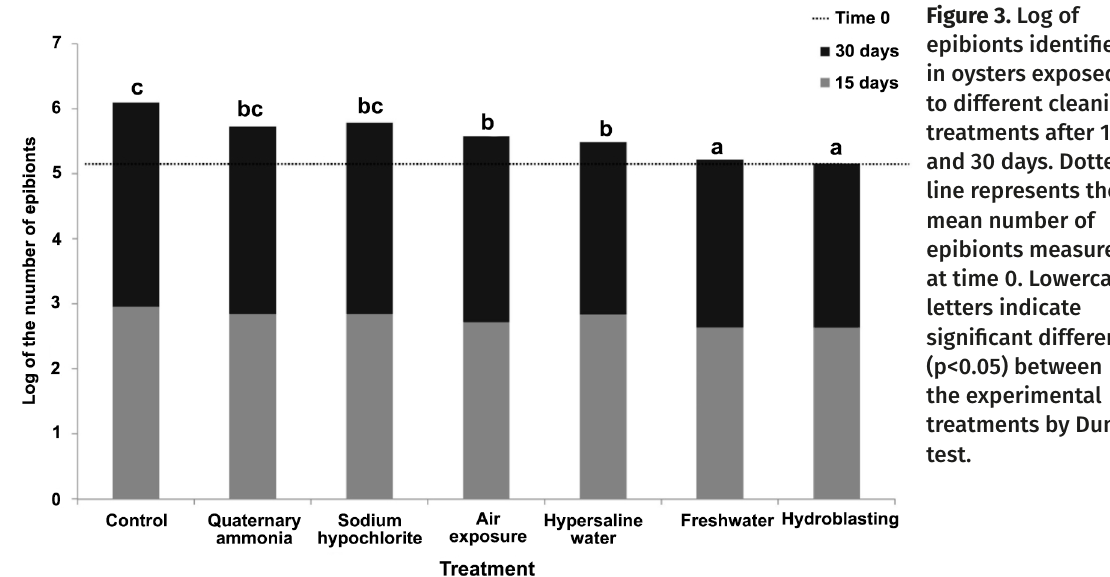
Figure 3. Log of epibionts identified in oysters exposed to different cleaning treatments after 15 and 30 days. Dotted line represents the mean number of epibionts measured at time 0. Lowercase letters indicate significant differences (p<0.05) between the experimental treatments by Duncan